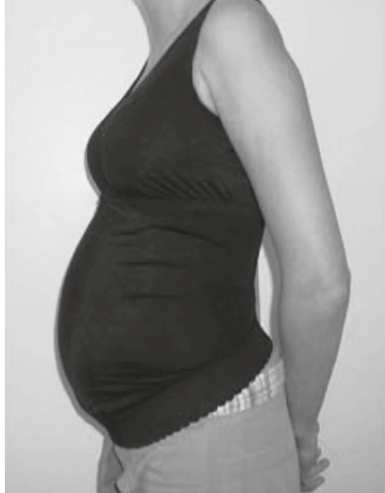
Figure 9: BellyBra (cid:2) Source: Kalus, Kornman [12] Image by: Kalus, Kornman